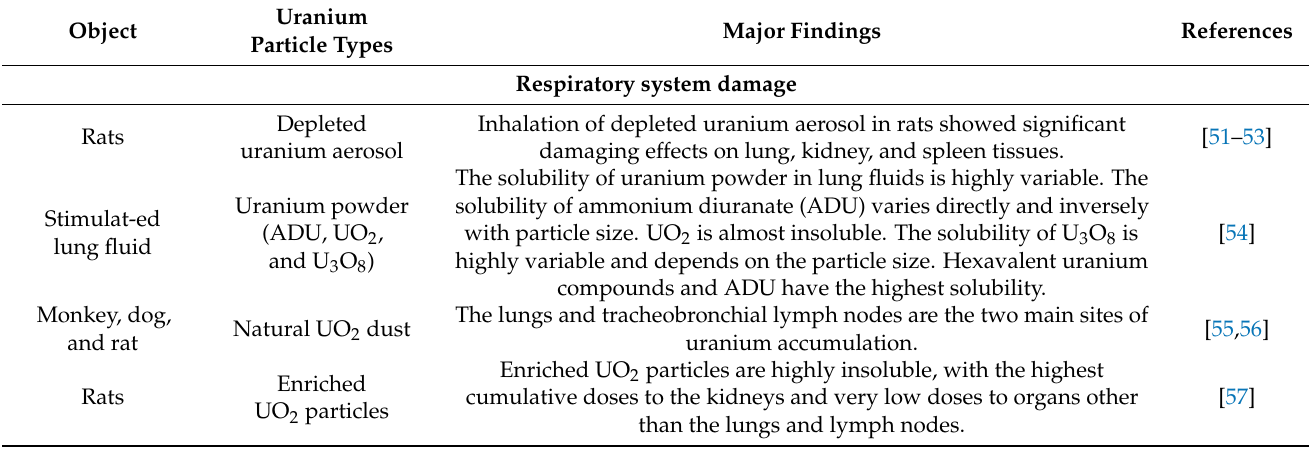
Table 1. In vivo studies of biological effects exposure to particulate